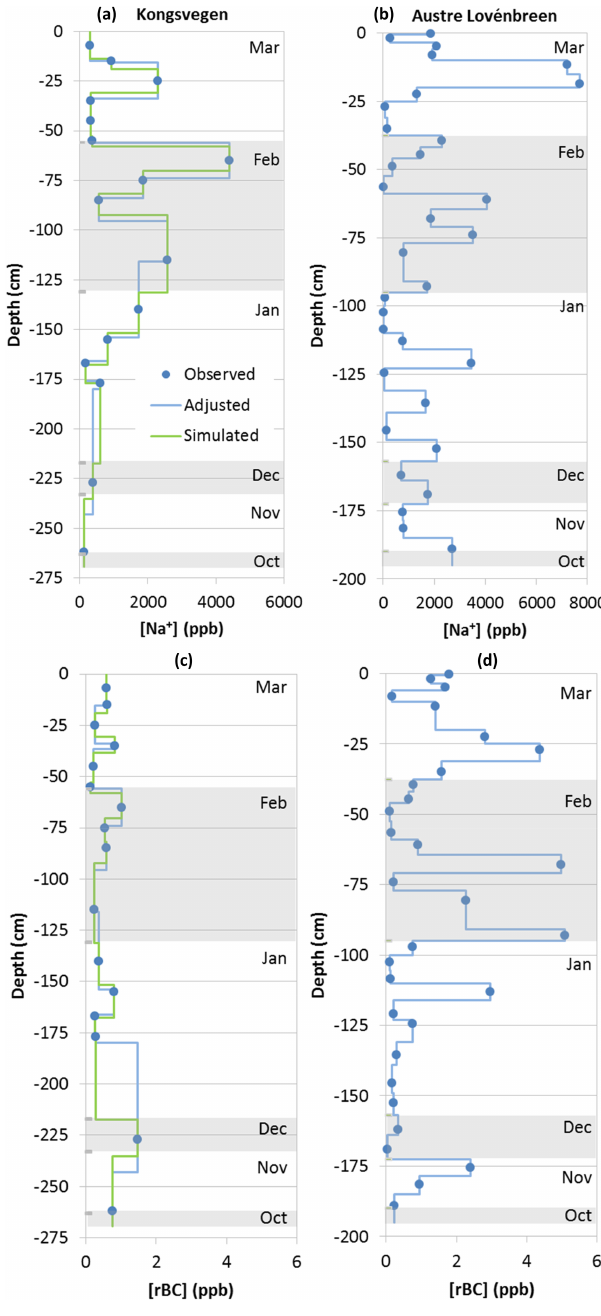
Figure 3. Sodium (a, b) and rBC concentrations (c, d) in the snow pits KV (a, c) and AL (b, d) . Blue circles indicate observed con- centrations, and blue lines correspond to concentrations adjusted to the observed stratigraphy. The green line shows concentrations ad- justed to the simulated stratigraphy for the snow pit KV. The alter- nating shaded and non-shaded areas correspond from the top to the months March to